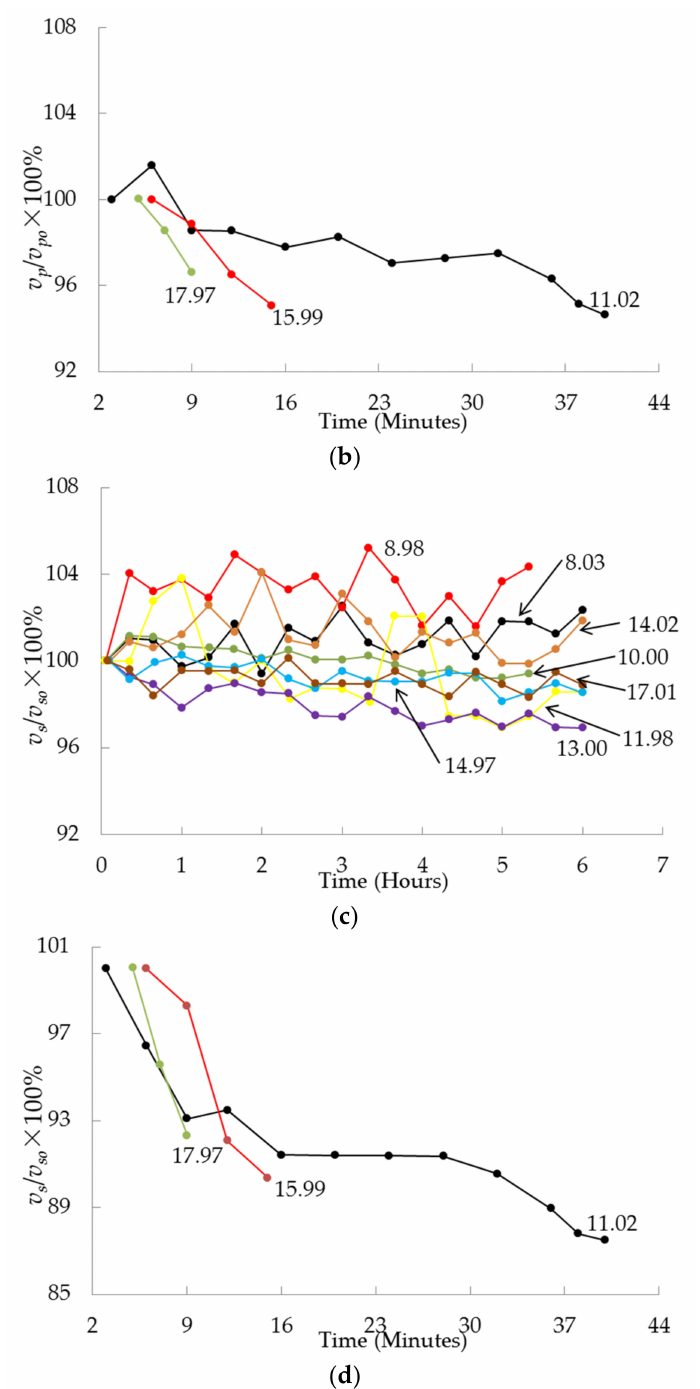
Figure 9. Graphs showing the changes in ultrasonic velocities during creep tests: ( a ) P-wave velocities of coal samples measured at 8.03 MPa, 8.98 MPa, 10.00 MPa, 11.98 MPa, 13.00 MPa, 14.02 MPa, 14.97 MPa, and 17.01 MPa; ( b ) P-wave velocities of coal samples measured at 11.02 MPa, 15.99 MPa, and 17.97 MPa; ( c ) S-wave velocities of coal samples measured at 8.03 MPa, 8.98 MPa, 10.00 MPa, 11.98 MPa, 13.00 MPa, 14.02 MPa, 14.97 MPa, and 17.01 MPa; ( d ) S-wave velocities of coal samples measured at 11.02 MPa, 15.99 MPa, and 17.97